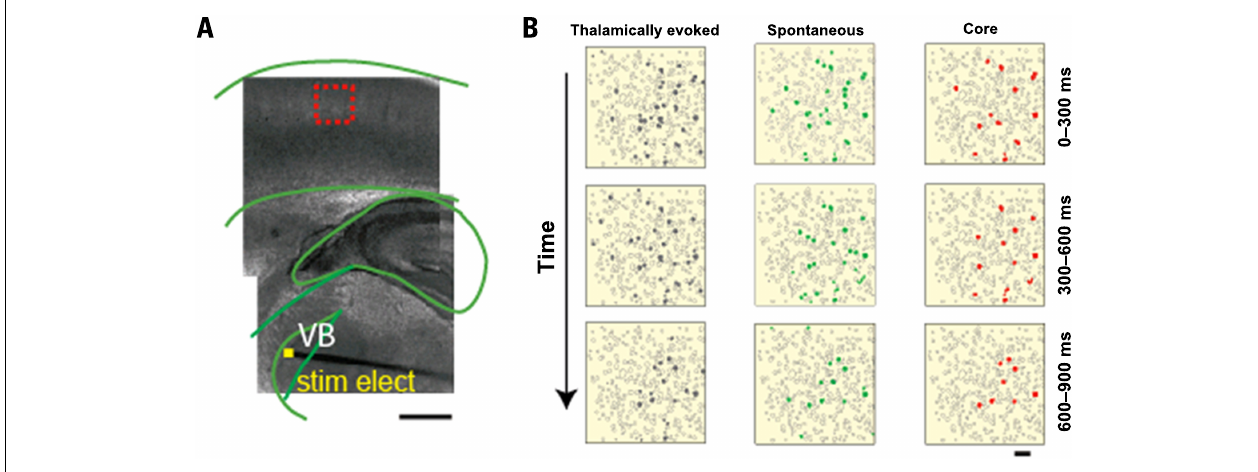
FIGURE 1 | Spatiotemporal precision of network activation: cells are activated in similar order spontaneously and following thalamic stimulation. (A) Light micrograph, with an overlaid cartoon, of a somatosensory (S1) thalamocortical slice preparation with intact thalamic input nucleus (ventral basal nucleus,VB), thalamocortical axons, and the somatosensory cortex. A stimulating electrode is placed inVB, as indicated by yellow square.The superimposed dashed-red box indicates the location,